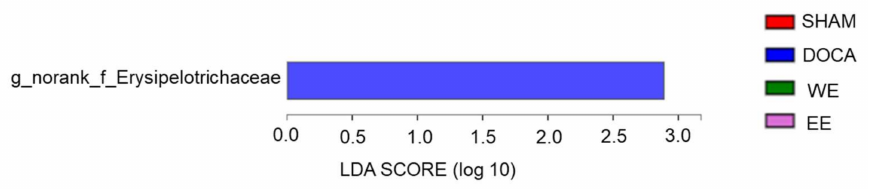
Figure A4. Phylogenetic distribution of gut microbiota of rats in SHAM, DOCA, WE and EE at week 0. Indicator bacteria with LDA scores of 2 or greater in bacterial